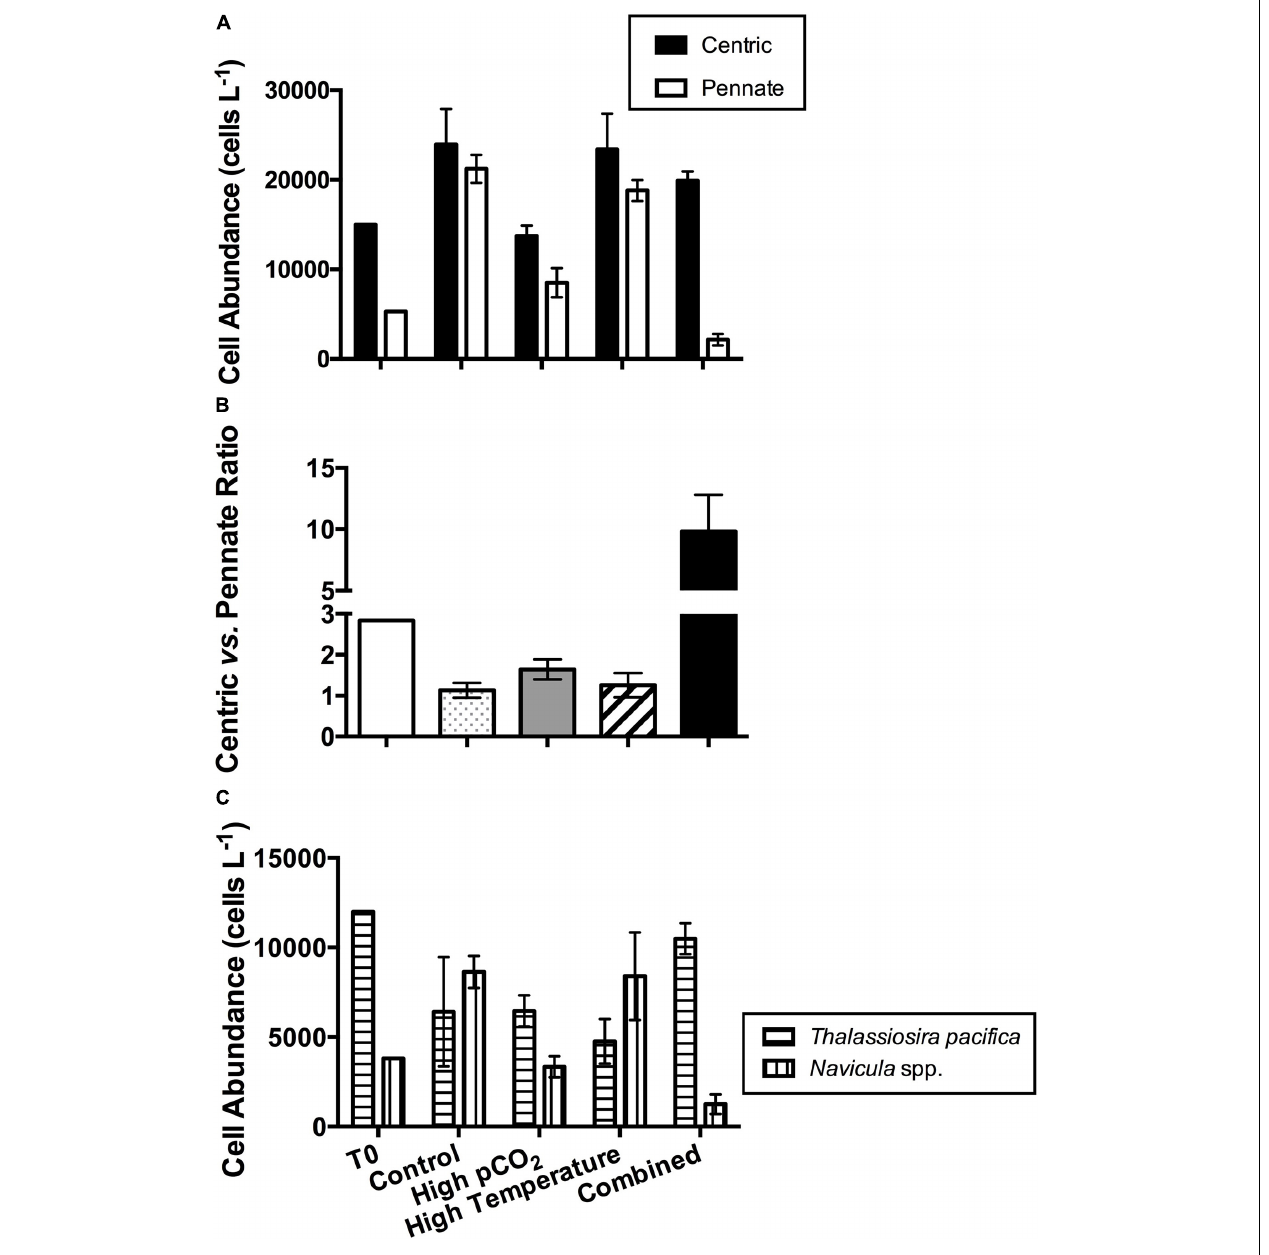
FIGURE 4 | Diatom assemblage composition in the four experimental treatments in the beginning of the incubation (T0) and on the final sampling day: (A) cell abundances of centric and pennate diatoms; (B) ratio of centric diatom to pennate diatom cell abundances; (C) cell abundances of dominant diatom species. Values are the means and error bars are the standard deviations of